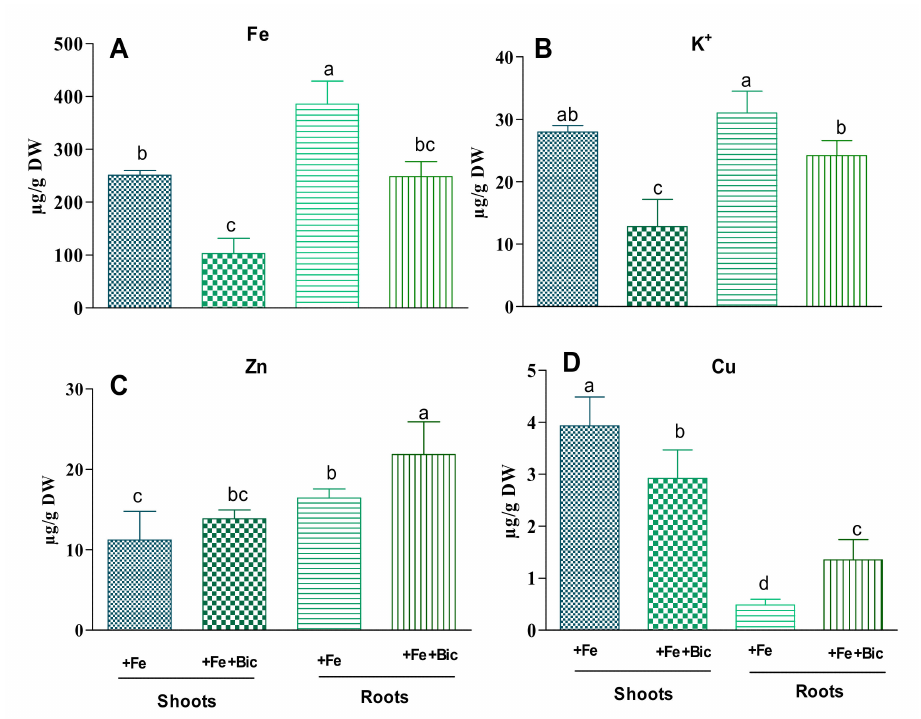
Figure 3. Iron (Fe; A ), potassium (K; B ), zinc (Zn; C ) and copper (Cu; D ) contents in shoots and roots of fennel plants grown under Fe sufficiency (+Fe) or under Fe deficiency conditions (+Fe +Bic). DW, dry weight; FW, fresh weight. Data represent the mean ± standard deviation of three independent assays. Values in the same line with different superscripts (a, b) are significantly different at p <